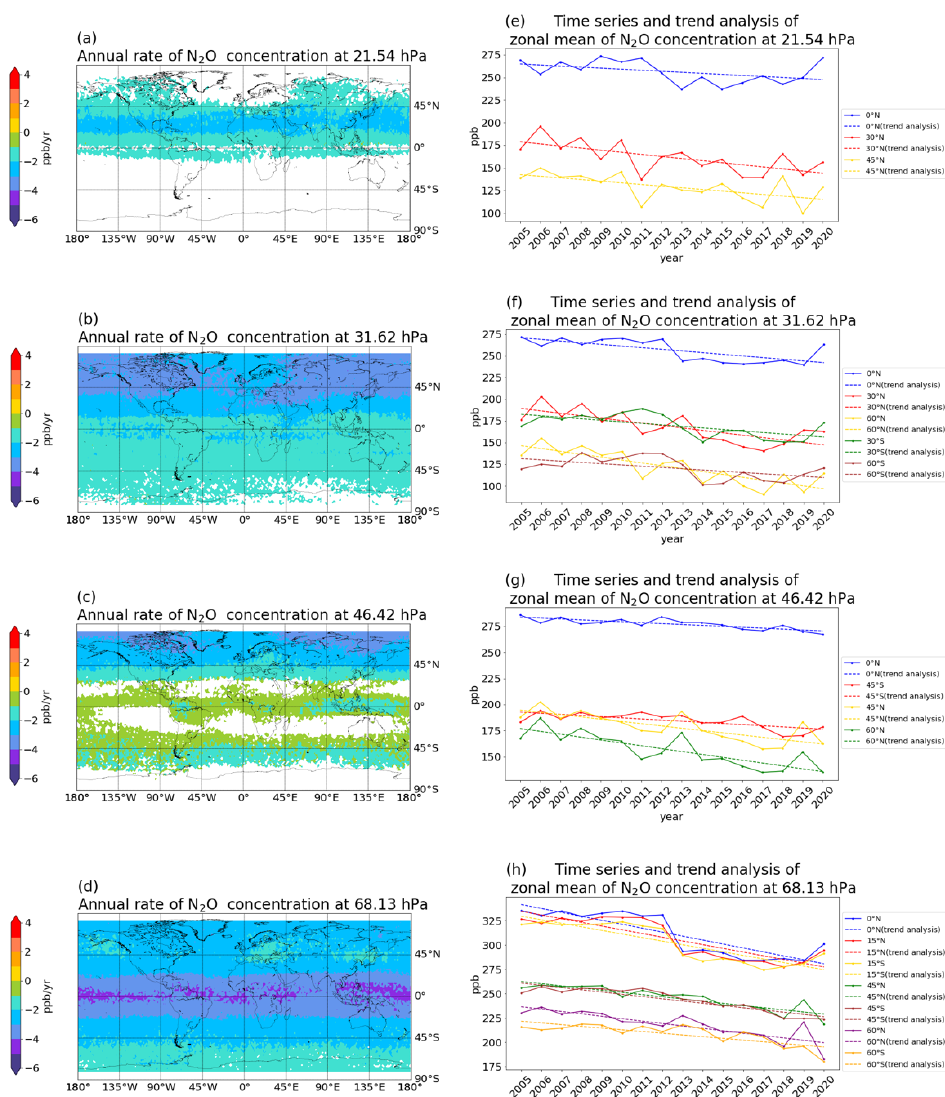
Figure 2. ( a – d ) Annual rate of N 2 O concentration at pressure levels of 21.54 hPa, 31.62 hPa, 46.42 hPa, and 68.13 hPa from 2005 to 2020, respectively; ( e – h ) zonal mean time series and trend analysis of N 2 O concentration at pressure levels of 21.54 hPa, 31.62 hPa, 46.42 hPa, and 68.13 hPa from 2005 to 2020, respectively. Only trends with a confidence level greater than 90% are shown on the graph.